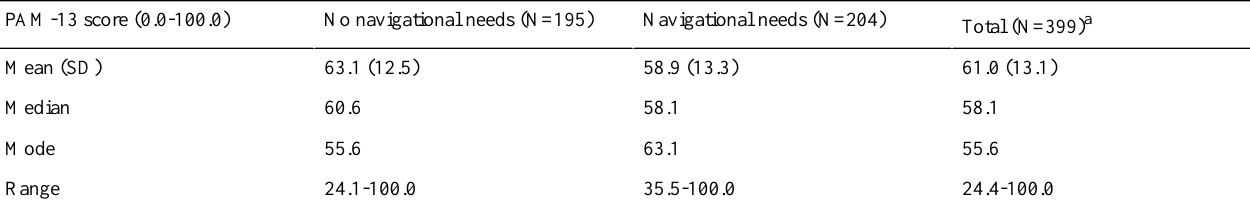
Table 5. Summary statistics: PAM-13 scores.